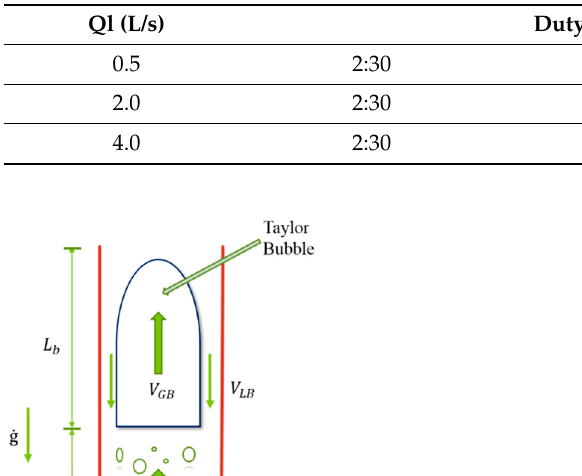
Table 1. Air valve duty cycle at various water flow rates.